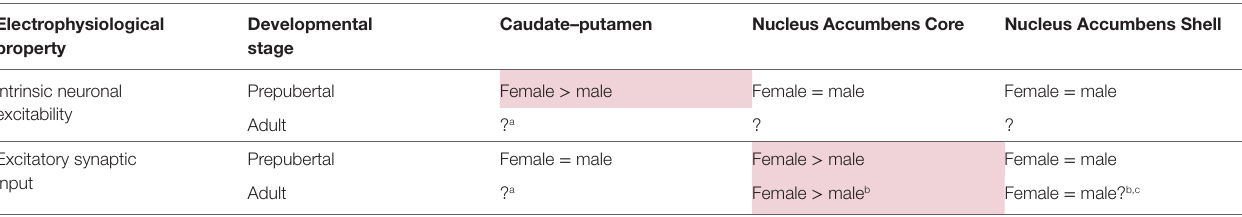
TABLe 1 | Development of sex differences in MSN electrophysiological properties varies by striatal